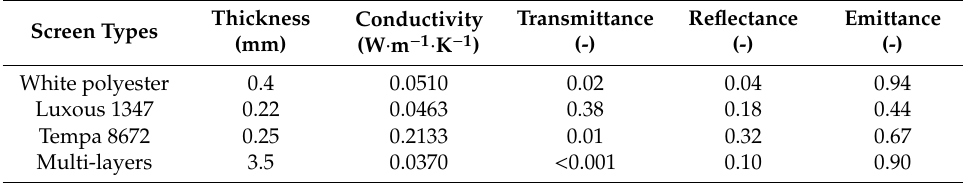
Table 4. Physical and thermal properties of the thermal screens.